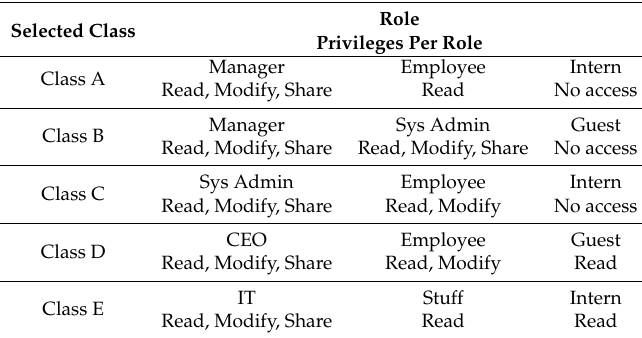
Table 5. Roles and privileges per class.